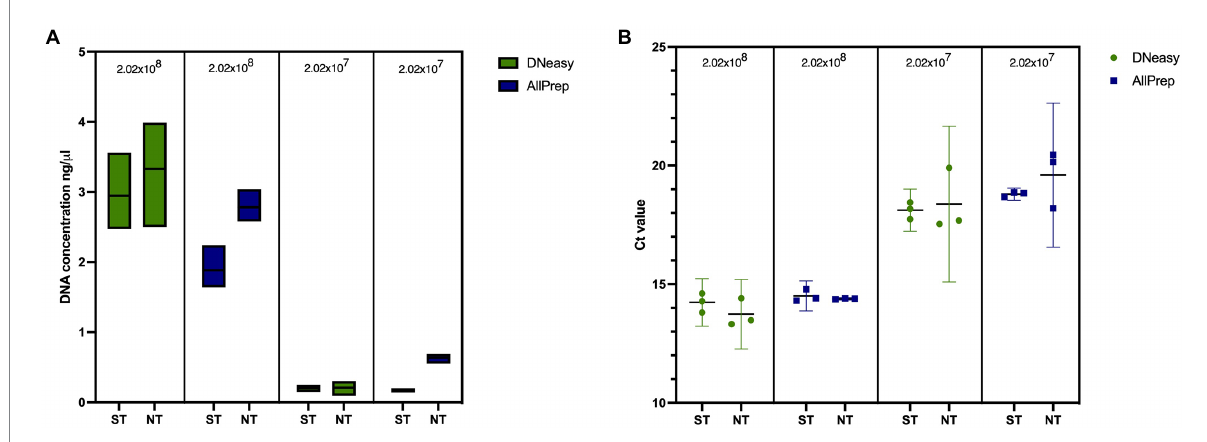
FIGURE 3 Effect of saponin and two DNA extraction kits on artificial sputum samples in terms of (A) DNA concentration measured with Qubit TM 2.0 and (B) qPCR targeting the 16S rRNA gene in spiked artificial sputum. ST, saponin treated; NT, not